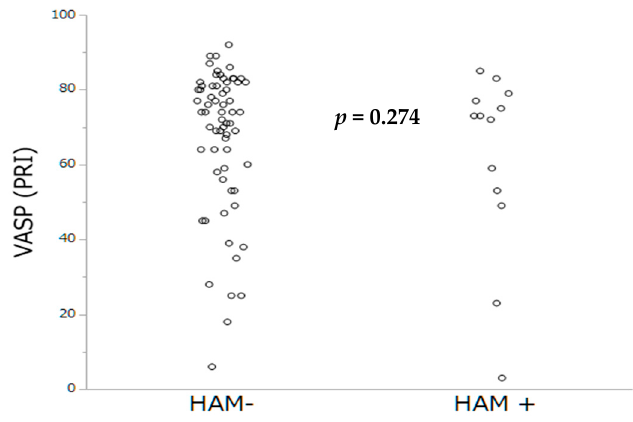
Figure 3. Occlusion time by CT-ADP according to the occurrence of HAM